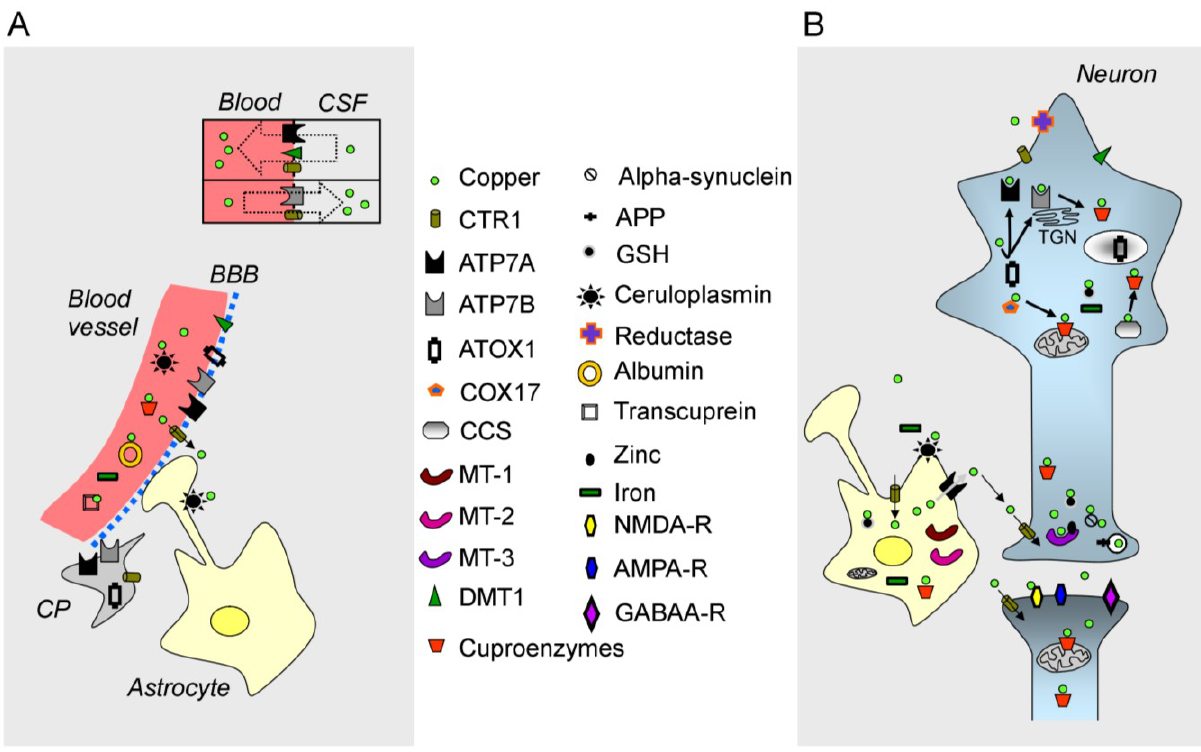
Figure 1. Illustration of copper metabolism in the central nervous system (CNS). ( A ) A blood vessel (in red on the left), the blood-brain barrier (BBB), the blood-CSF barrier (shown by a rectangle with two compartments), a choroid plexus (CP) and an astrocyte are illustrated; ( B ) A neuron, a synapse and an astrocyte are shown. Copper is represented by a green circle. At the blood-CSF barrier, CTR1 (copper transporter 1), DMT1 (divalent metal transporter) and the ATPase, ATP7A, transport copper towards the blood, whereas the ATPase, ATP7B, and CTR1 transport copper in the opposite direction. Organelles and proteins involved in the cellular regulation of copper are represented. CTR1 is the main transporter for transferring copper within cells. Chaperones (ATOX1, COX17, CCS) deliver copper to the ATPases, ATP7A/ATP7B, and to cuproenzymes, including in the mitochondria. Metallothioneins (MT-1, MT-2, MT-3) exert a function as a buffer. Copper is also found in secretory granules. Abbreviations: APP, amyloid precursor protein; GSH, glutathione; NMDA-R, NMDA receptor; AMPA-R, AMPA receptor; GABAA-R, GABAA receptor; TGN, trans-Golgi